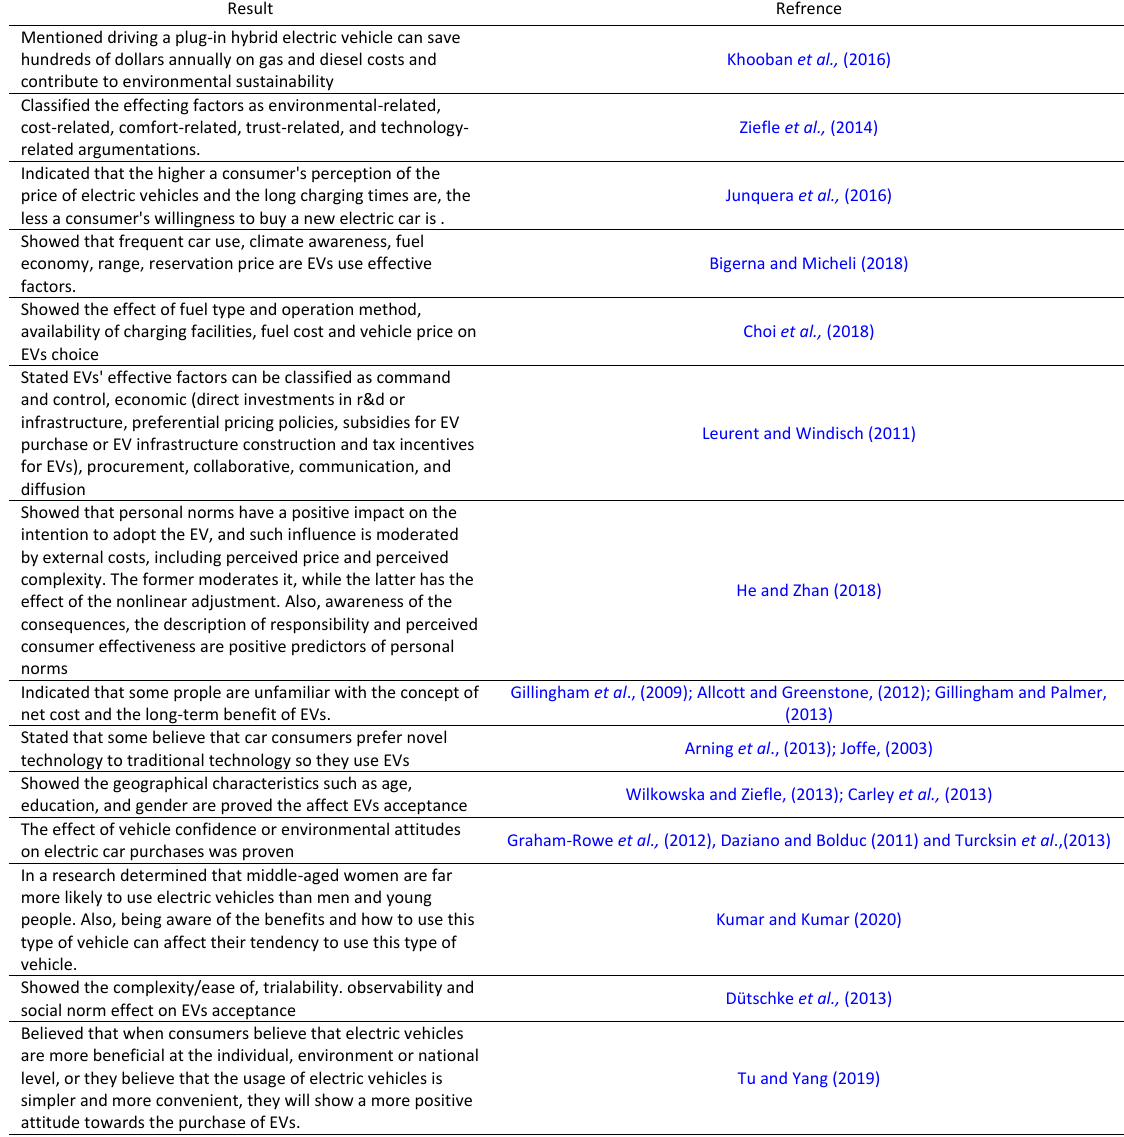
Table 1: important previous studies about EVs acceptance